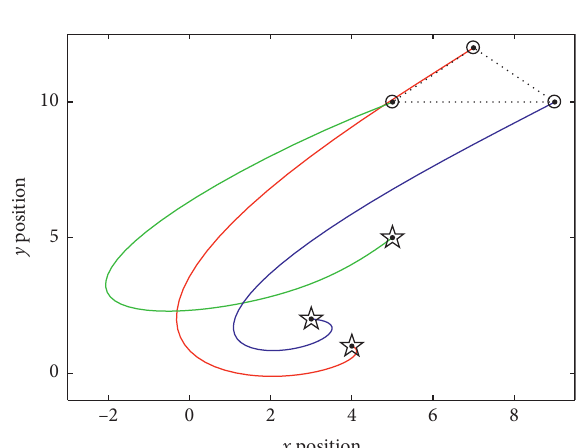
Figure 7: A triangle